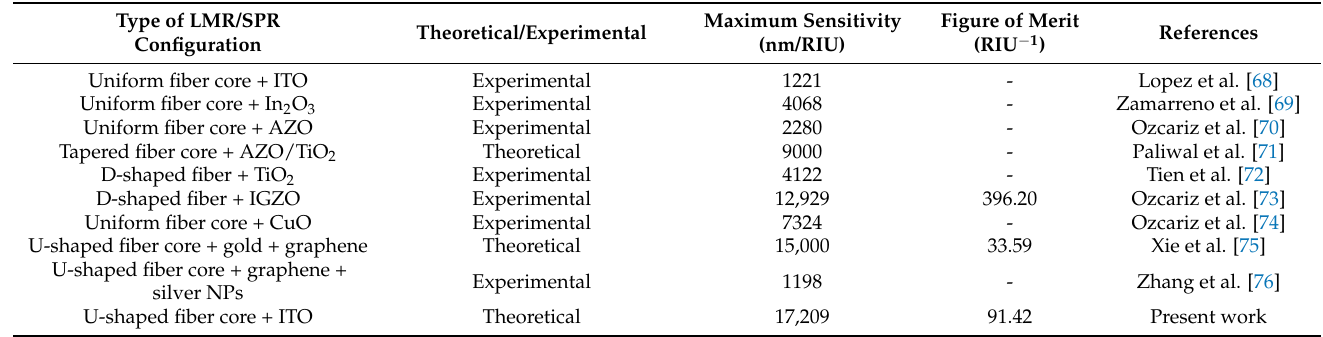
Table 3. Sensitivity comparison of the designed LMR sensor with previously reported LMR/SPR